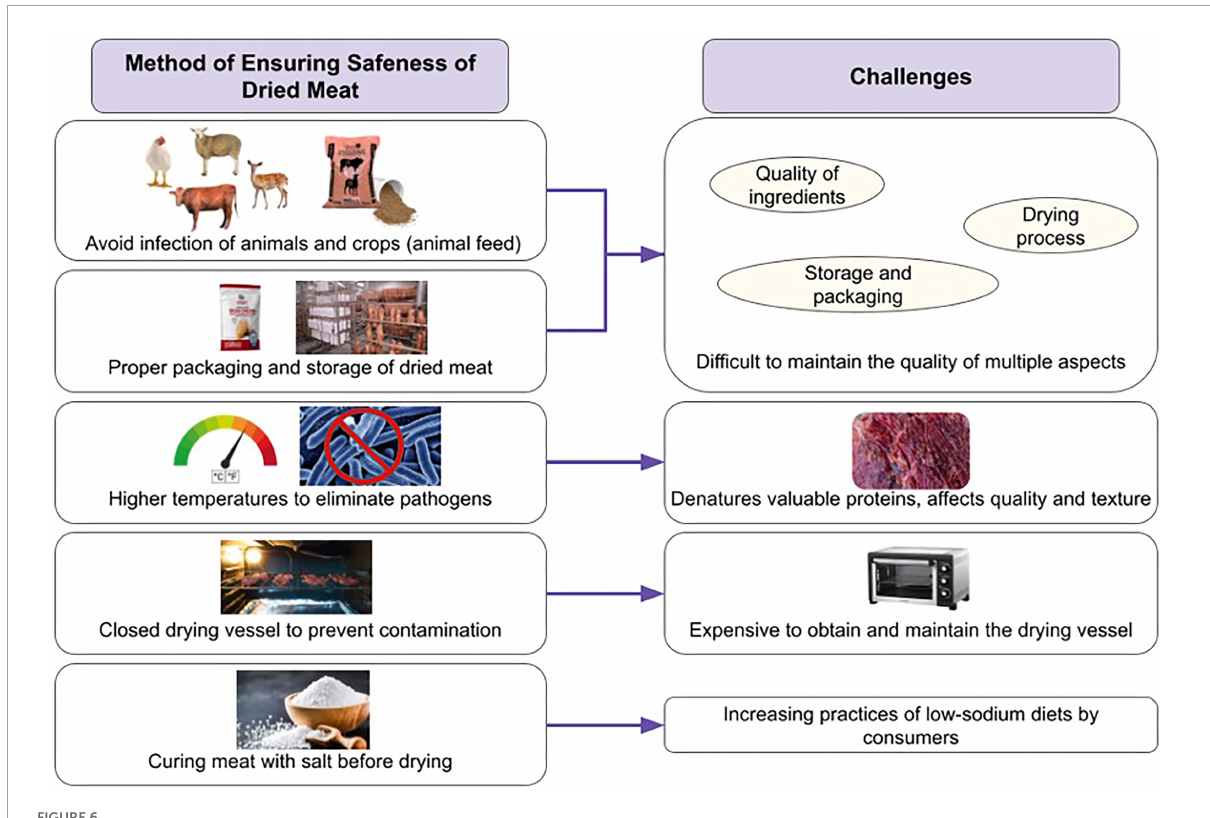
FIGURE6 Methods of ensuring the safeness of dried meat along with their challenges.